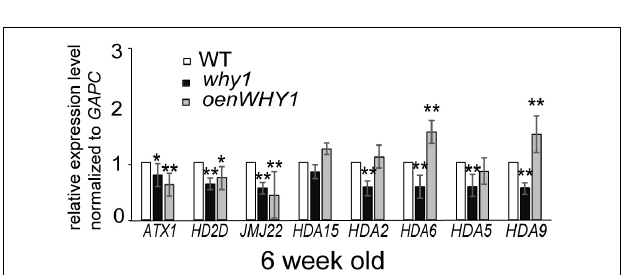
FIGURE 6 | WHIRLY1 affects the HDAs gene expression. The expression of histone modification-related genes in 6-week-old why1 , oenWHY1 , and wild-type (WT) plants by qRT-PCR. The transcript level in each case was normalized to that of GAPC2 as a reference gene, and the expression level at WT was set as 1. Three biological replicates and three technique replicates were used to analyze. Error bars represent SE. Asterisk indicate significant differences ( ∗ P < 0.05 and ∗∗ P < 0.01) based on Student’s t -test.